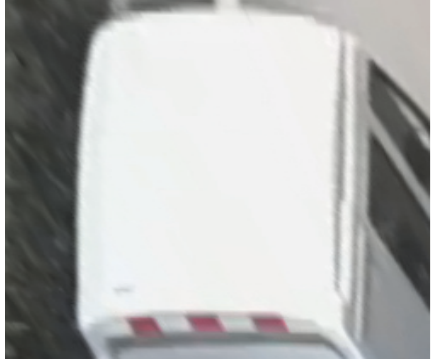
Figure 45: Inverse projection of the top view of van.